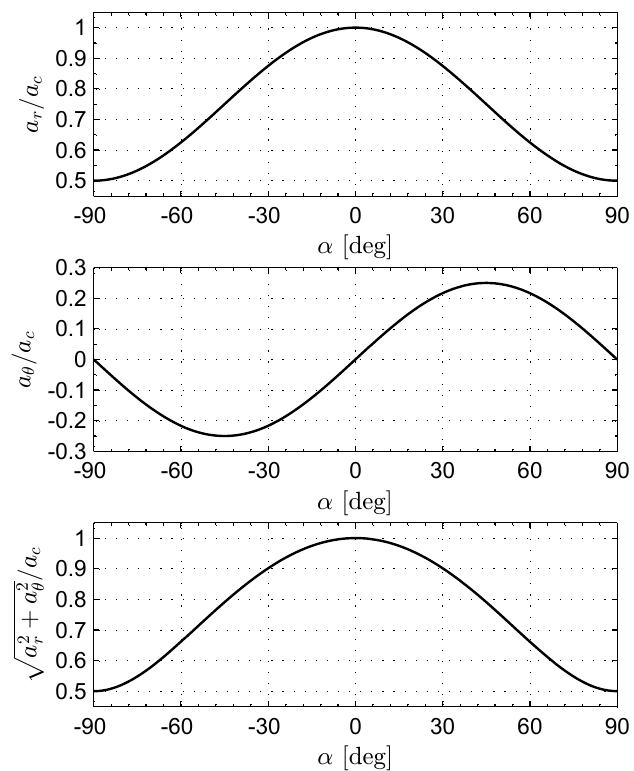
Figure 4. Variation of the propulsive acceleration (dimensionless) components and magnitude with the sail pitch angle when τ = 1 and r = r ⊕